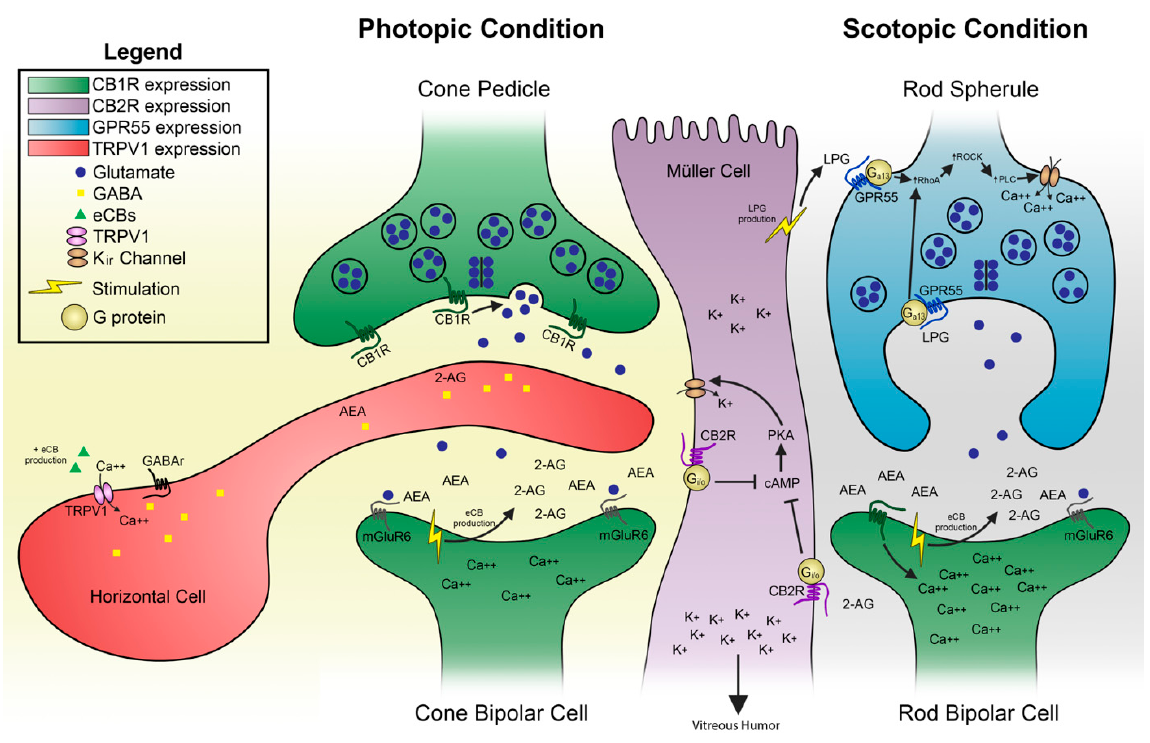
Figure 6. The hypothetical molecular mechanisms for typical and atypical cannabinoid receptors action in the retina is illustrated at the photoreceptor-bipolar cell synapse. This may also exist in several other synapses in the visual where this differential expression pattern exists. LPG, as suggested in previous models [30,41] , could be produced by Müller cells. Adapted from [30].